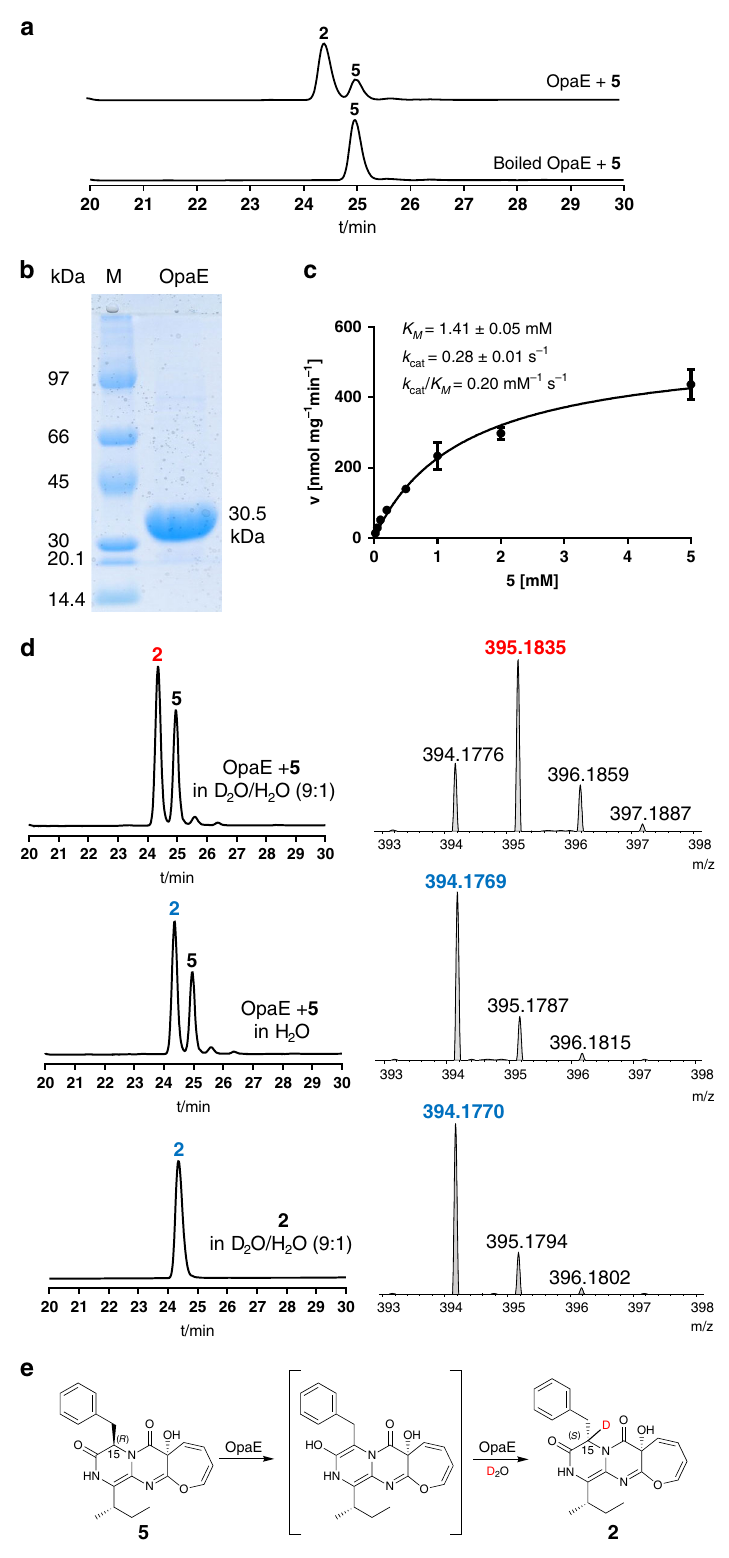
Fig. 5 In vitro veri fi cation of OpaE as a d-phenylalanyl epimerase. a HPLC analysis of in vitro assays with OpaE at 254 nm. b SDS-PAGE analysis of the puri fi ed OpaE. The experiments were repeated twice. c Determination of the kinetic parameters for OpaE with 5 .The error bars represent standard errors of velocity and SEMs are given as ± values ( n = six independent experiments). d LC – MS monitoring of the OpaE reactions in D 2 O/H 2 O and negative controls. e Proposed mechanism for the OpaE